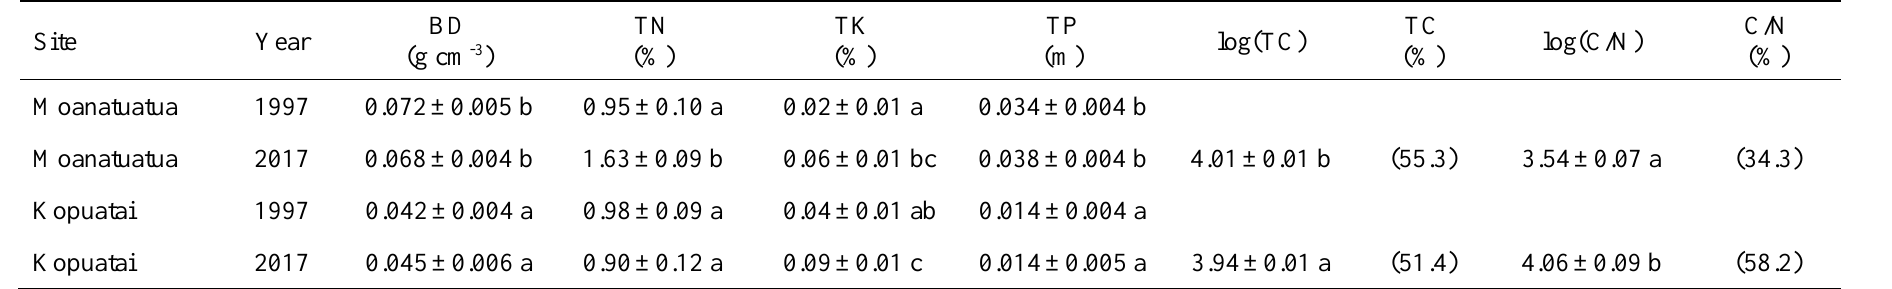
Table 3. Means (± standard error) for peat nutrients and associated variables (bulk density (BD), total nitrogen (TN), total potassium (TK), total phosphorus (TP), total carbon (TC) and carbon/nitrogen quotient (C/N)), from the residual maximum likelihood (REML) analysis, for modified (Moanatuatua) and reference (Kopuatai) bogs in 1997 and 2017. For the natural log transformed total carbon and C/N, the back-transformed mean is given (in parentheses). For each variable, means without a letter in common are significantly different.